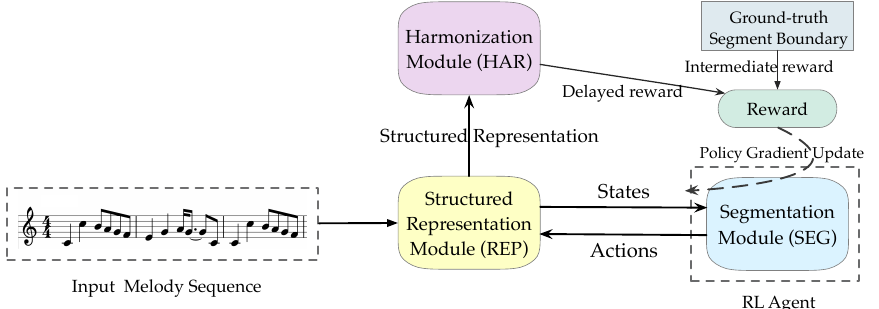
Figure 2. The overall process of our